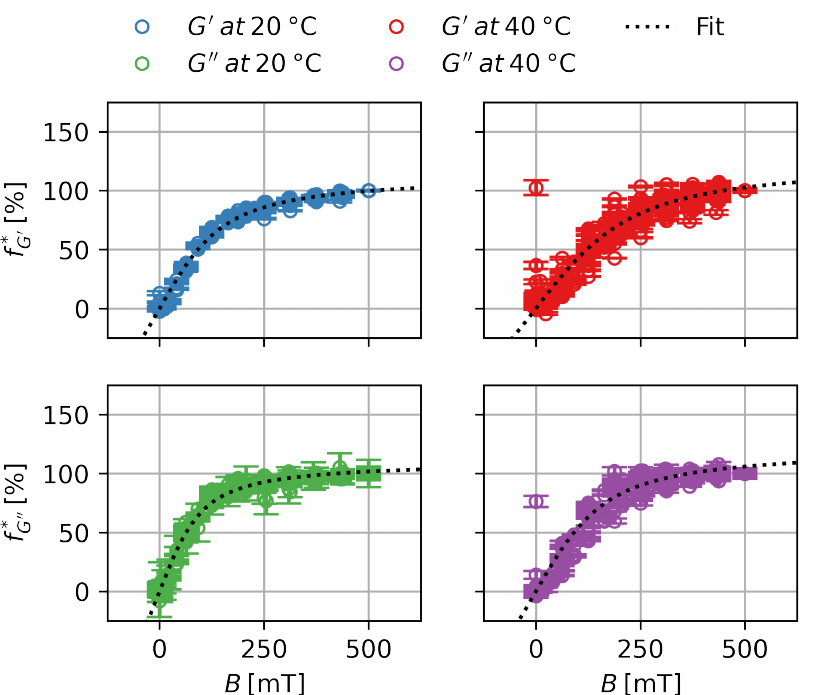
Figure 8. Magnetorheological effect normalized to the maximum effect at B = 500mT over the magnetic flux density for the storage and loss modulus in the swollen and deswollen state.